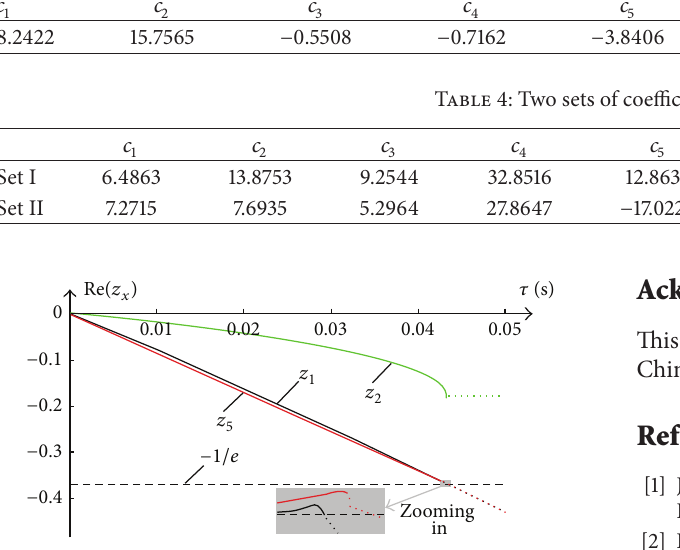
Figure 16: Curves of 𝜏 - 𝑧 1 , 𝜏 - 𝑧 2 , and 𝜏 - 𝑧 5 with set I of Table 4.